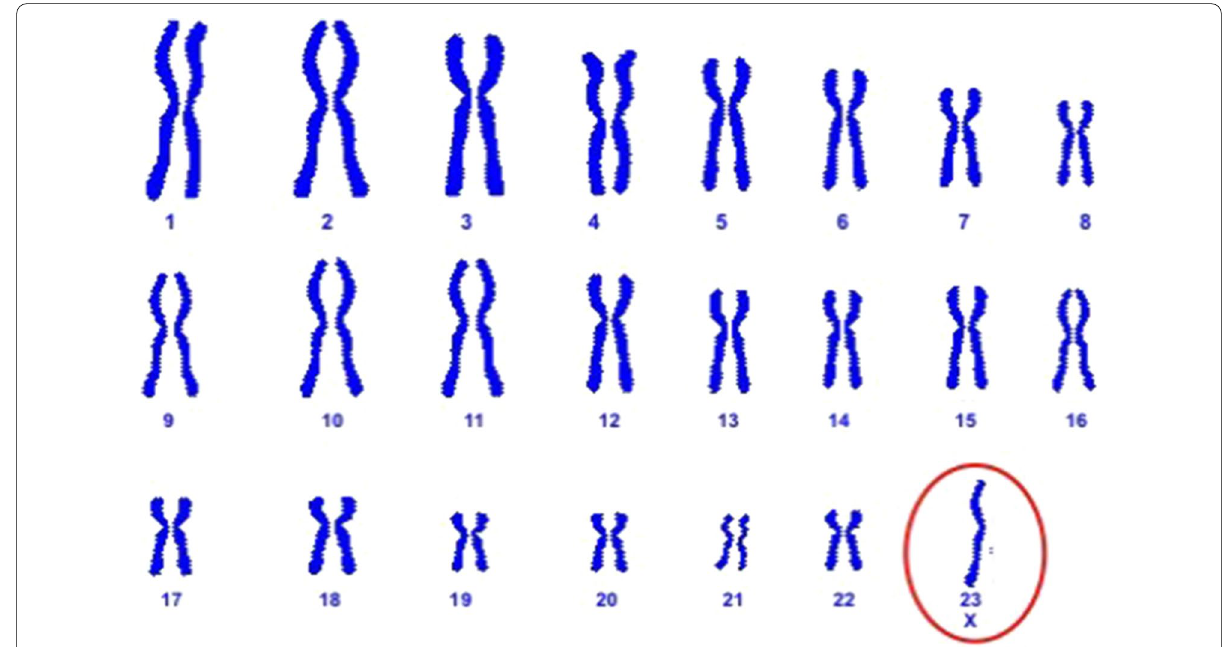
Fig. 5 A karyogram of Turner